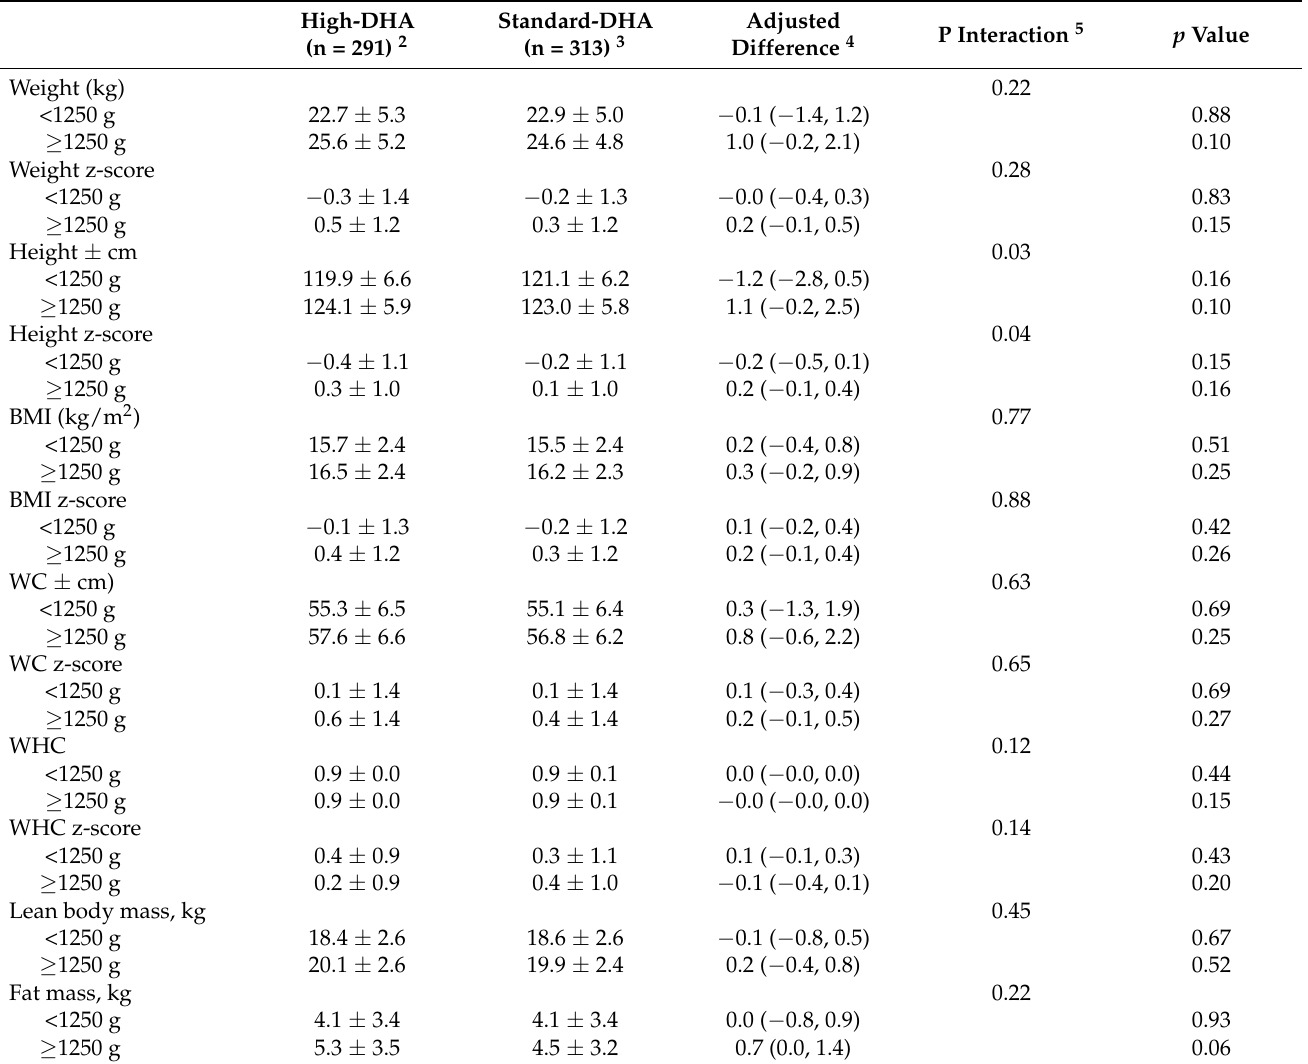
Table 4. Comparison of growth and body composition at 7-year corrected age, stratified by child birthweight strata (<1250 g and ≥ 1250 g) and treatment group 1